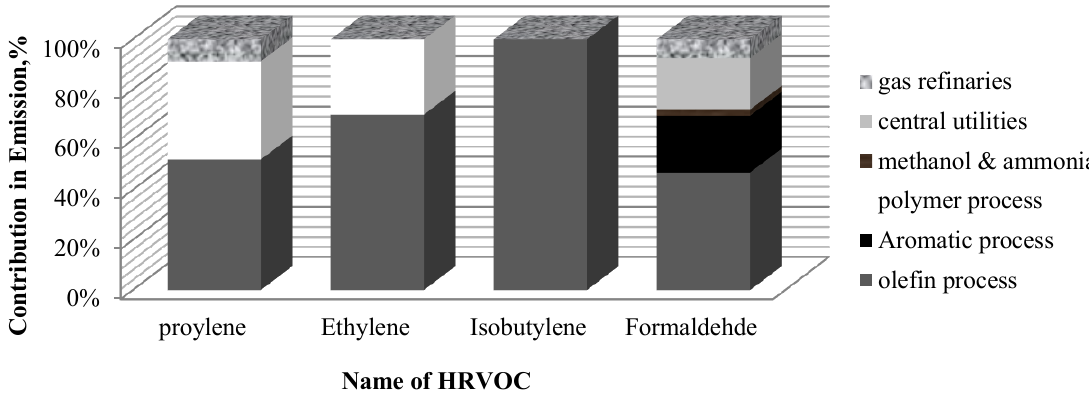
Figure 5. Process types’ contribution in HRVOCs Emission in the SPZ, % Representative high ozone episode was selected for each. Then an "averaged conditions" scenario was derived from the averages of the relevant inputs of the 39 base case